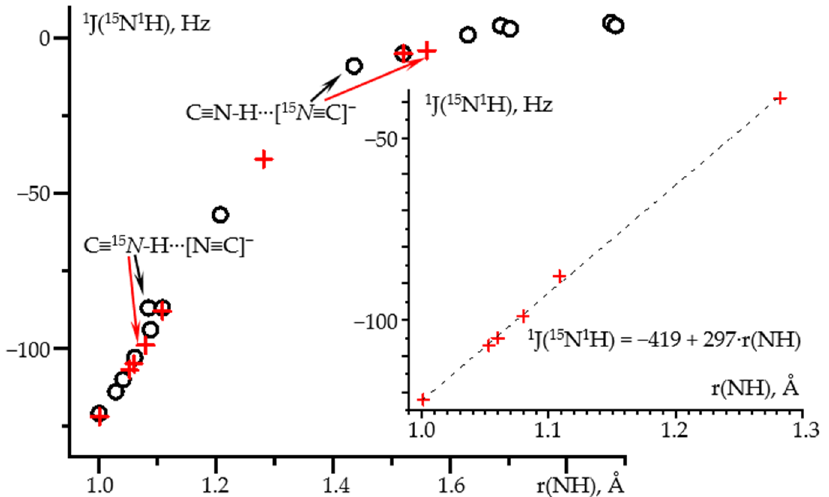
Figure 1. 1 J( 15 N 1 H) as a function of the N-H distance in hydrogen-bonded complexes of C ≡ 15 N- 1 H obtained at different approximations and PCM = water. Geometry optimization at the wB97XD/def2tzvp and NMR at the GIAO wB97XD/pcJ-2 approximations (black circles). Geometry optimization at the MP2/def2qzvpp and NMR at the GIAO wB97XD/pcJ-3 approximations (red crosses). Insert: the distance range at which this dependence is linear.